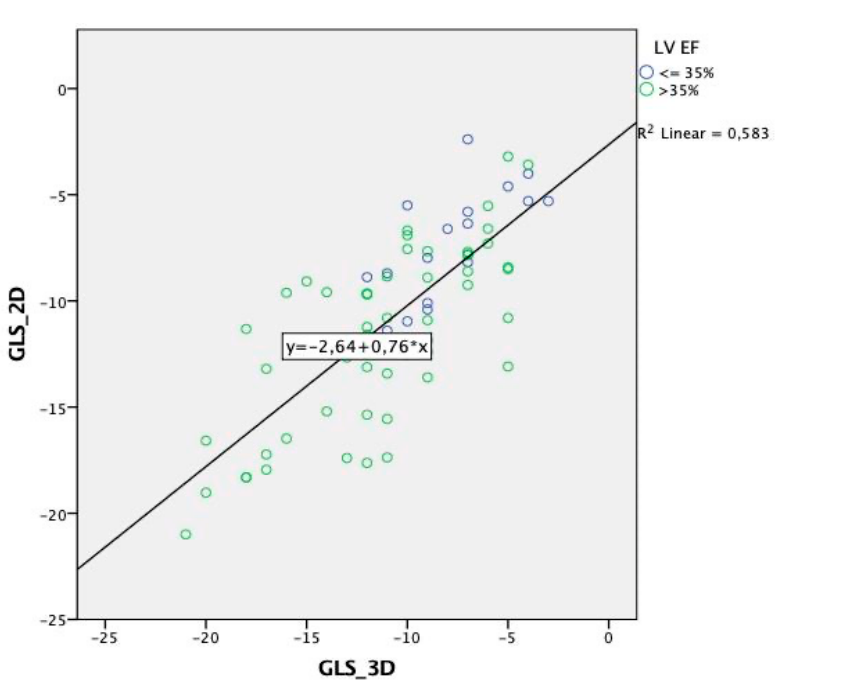
Figure 5. Scatter plot of 2D vs. 3D global longitudinal strain. Sorted by the amount of right ventric- ular pacing (VP) with displayed regression equation.